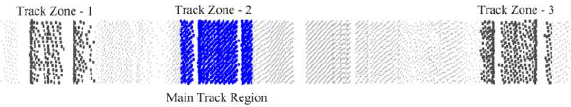
Figure 4. Potential railway track zone detection (dark gray color) and the main track region determination (blue color) in the initial